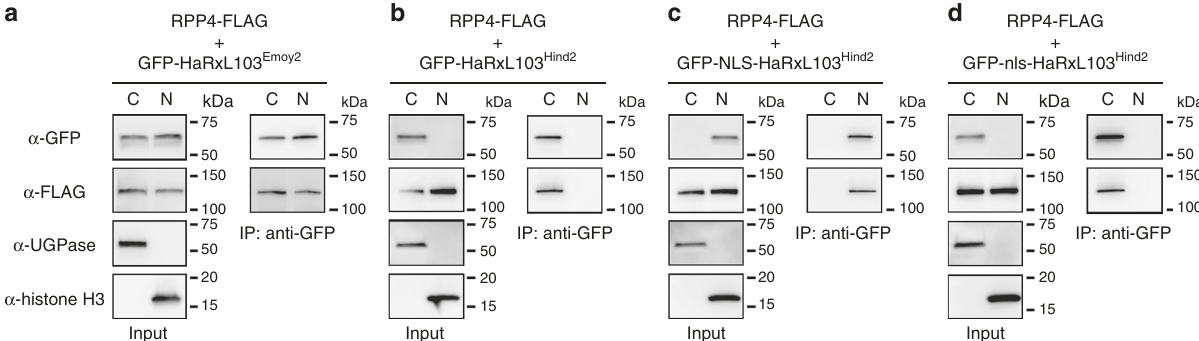
Fig. 5 Interactions between HaRxL103 Emoy2 /HaRxL103 Hind2 and RPP4 in cytoplasm and/or nucleus. In planta interaction of GFP-HaRxL103 Emoy2 ( a ), GFP- HaRxL103 Hind2 ( b ), and GFP-NLS/nls-HaRxL103 Hind2 ( c , d ) with RPP4-FLAG in cytoplasm and nucleus. Cytoplasmic (C) and nuclear (N) protein extracts were separately isolated from N. benthamiana leaves inoculated with Agrobacterium containing the indicated gene constructs at 2 dpi. Co- immunoprecipitation was performed with each extract using MACS MicroBeads with GFP antibody. Anti-GFP (upper panel), anti-FLAG (the 2nd panel), anti-UGPase (the 3rd panel), and anti-Histone H3 antibodies (bottom panel) were used to detect the related proteins in the immunoprecipitates. UGPase and Histone H3 were checked as markers for cytoplasmic and nuclear proteins,